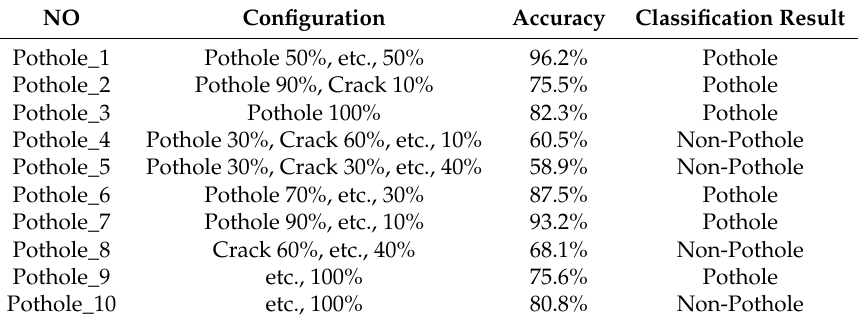
Table 3. The results of pothole classification accuracy using the proposed model.